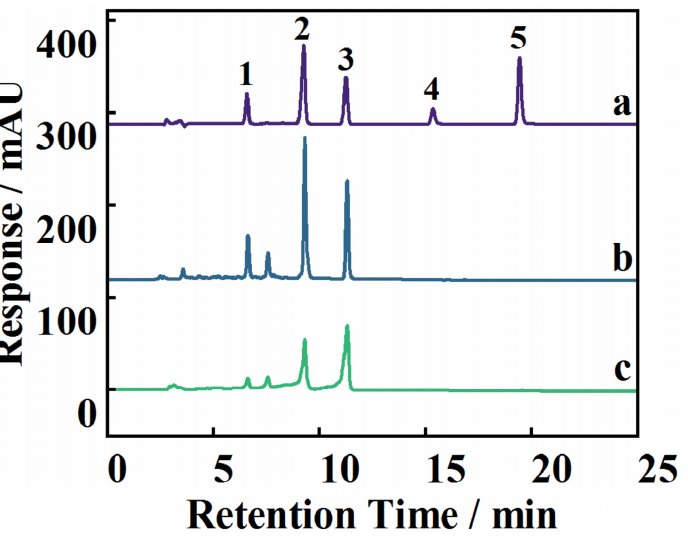
Figure 5. The chromatogram of five flavonoids’ mixed standards (a), the Dicranopteris pedata samples after MSPE (b), and the Dicranopteris pedata samples without MSPE (c). Note: 1, rutin; 2, quercitrin; 3, kaempferol-3-O- α -L-rhamnoside; 4, quercetin; 5, Table 2. Recovery results of five flavonoids ( n = 3).